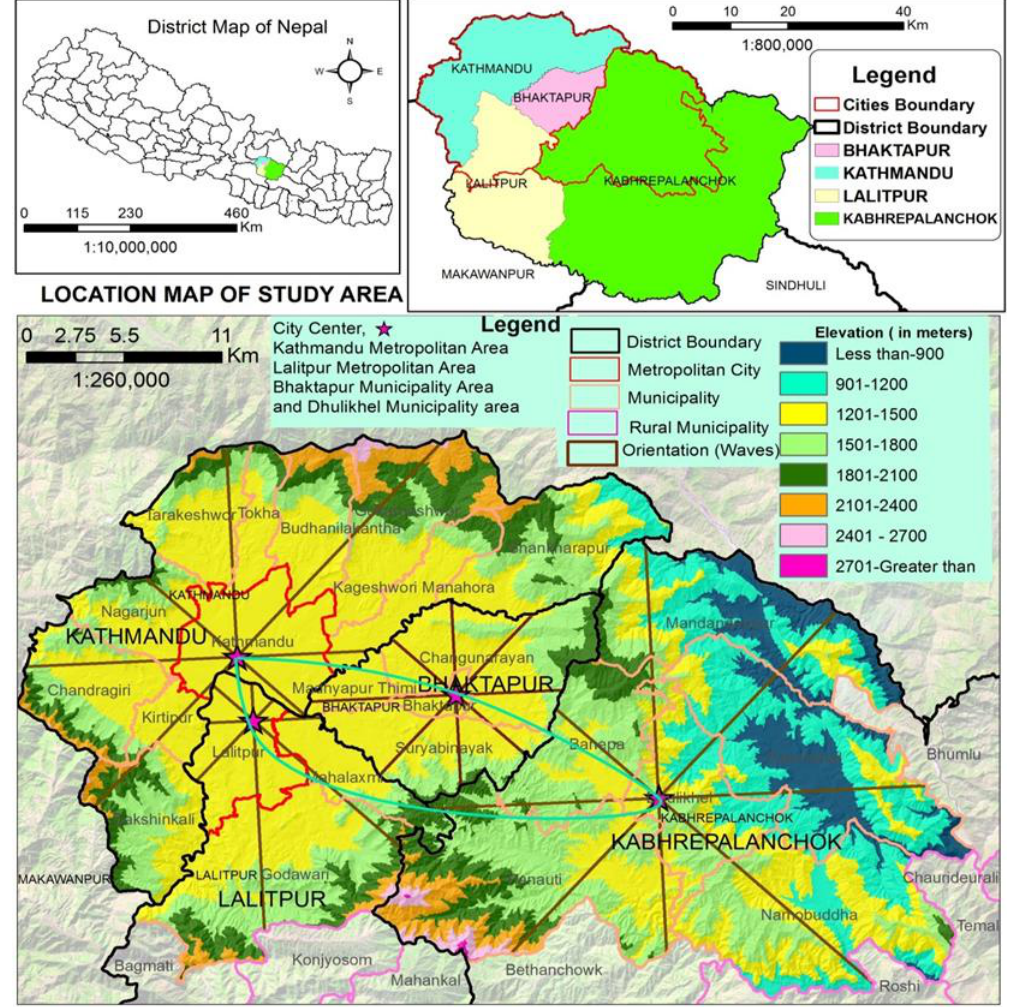
Figure 1. Location map of the study area.